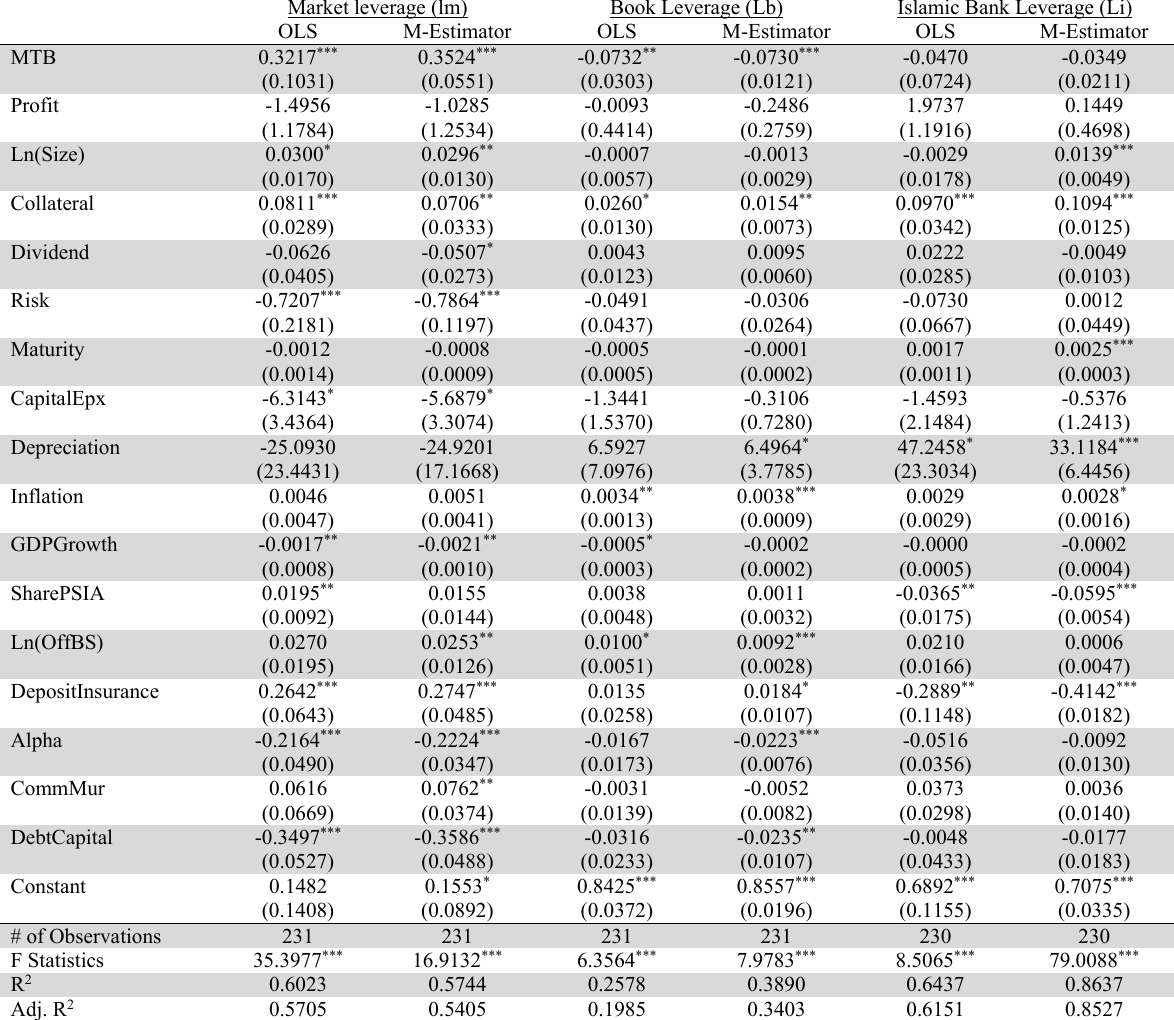
The full model of capital determinants in Islamic banks Market leverage